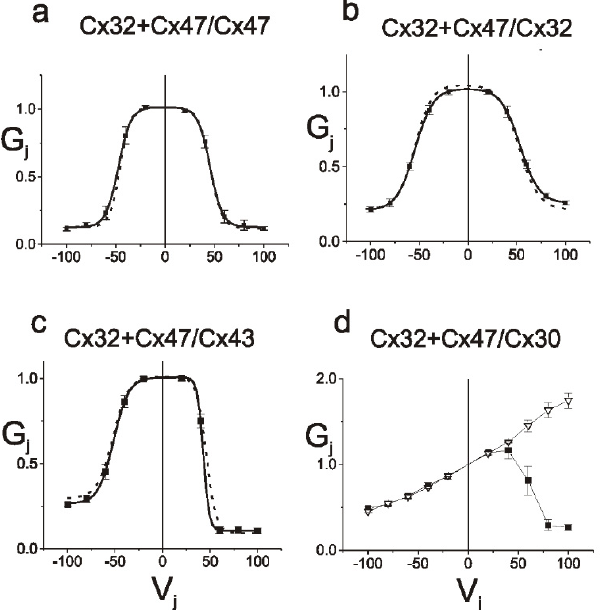
Figure 1. Properties of junctions between cells expressing Cx32 and Cx47 paired with cells expressing ( a ) Cx47, ( b ) Cx32, ( c ) Cx43 or ( d ) Cx30 alone. Average normalized steady state G j ‐ V j relations for Cx32+Cx47/Cx47, Cx32+Cx47/Cx32, Cx32+Cx47/Cx43 and Cx32+Cx47/Cx30 pairings are shown. The average normalized steady ‐ state (filled squares) junctional conductance (G j ) at each V j was calculated as described [63]. The solid lines are the best fit of the data to a double Boltzmann distribution as described in the Methods, and the dotted lines are the best fit of data for Cx47/Cx47, Cx32/Cx32, or Cx47/43 heterotypic junctions. G j -V j relations for Cx32+Cx47/Cx47, Cx32+Cx47/Cx32, Cx32+Cx47/Cx43, and Cx32+Cx47/Cx30 pairings are indistinguishable